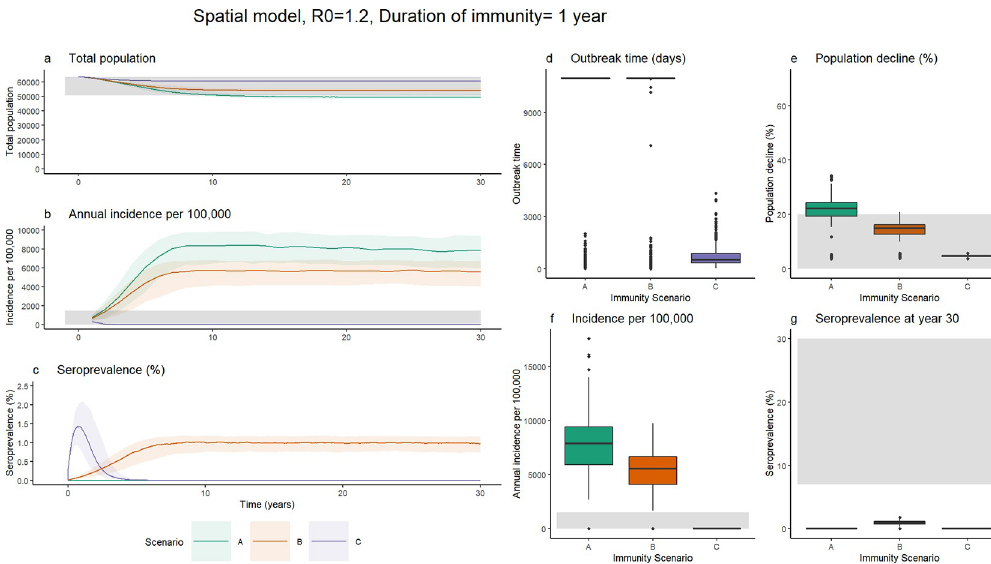
Fig 3. Results from the three immunity scenarios for the spatial model with R 0 = 1.2 and a 1-year duration of naturally acquired immunity. Median and interquartile range for the total population size, annual incidence and seroprevalence for each of the immunity scenarios over the 30-year simulation are shown in a-c respectively. Fig 3d–3g shows boxplots for the outbreak time (d) (time from introduction to no infectious individuals remaining, or end of simulation), population decline (e) relative to the carrying capacity, incidence per 100,000 dogs in year 30 post introduction (f) and predicted seroprevalence at the end of the simulation (g). Grey bands indicate the range of values considered plausible based on empirical estimates, as shown in Table